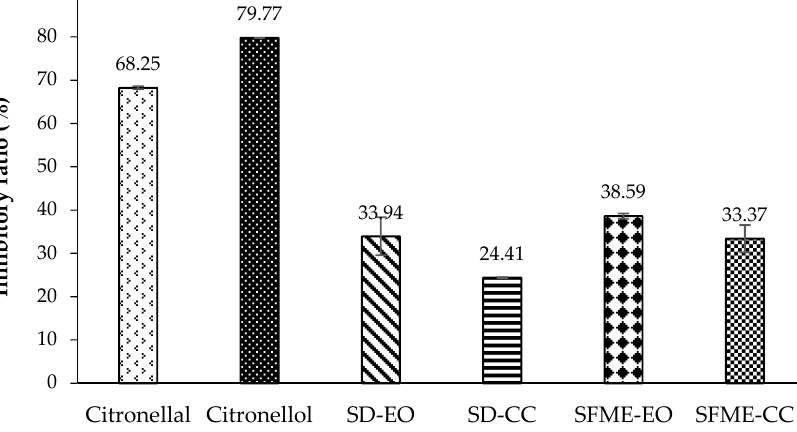
Figure 5. 5-Lipoxygenase (5-LOX) inhibitory ratio (%) of ‘Mato Peiyu’ leaf essential oils, citronellal, and citronellol. SD-EO, SFME-EO, citronellal, and citronellol were measured at a concentration of 0.0200% ( v / v ). SD-CC and SFME-CC were measured at concentrations of 0.0101% and 0.0120% ( v / v ) according to the composition ratios in 0.0200% ( v / v ) SD-EO and SFME-EO, respectively. Data are presented as the mean ± standard deviation based on triplicate determination.